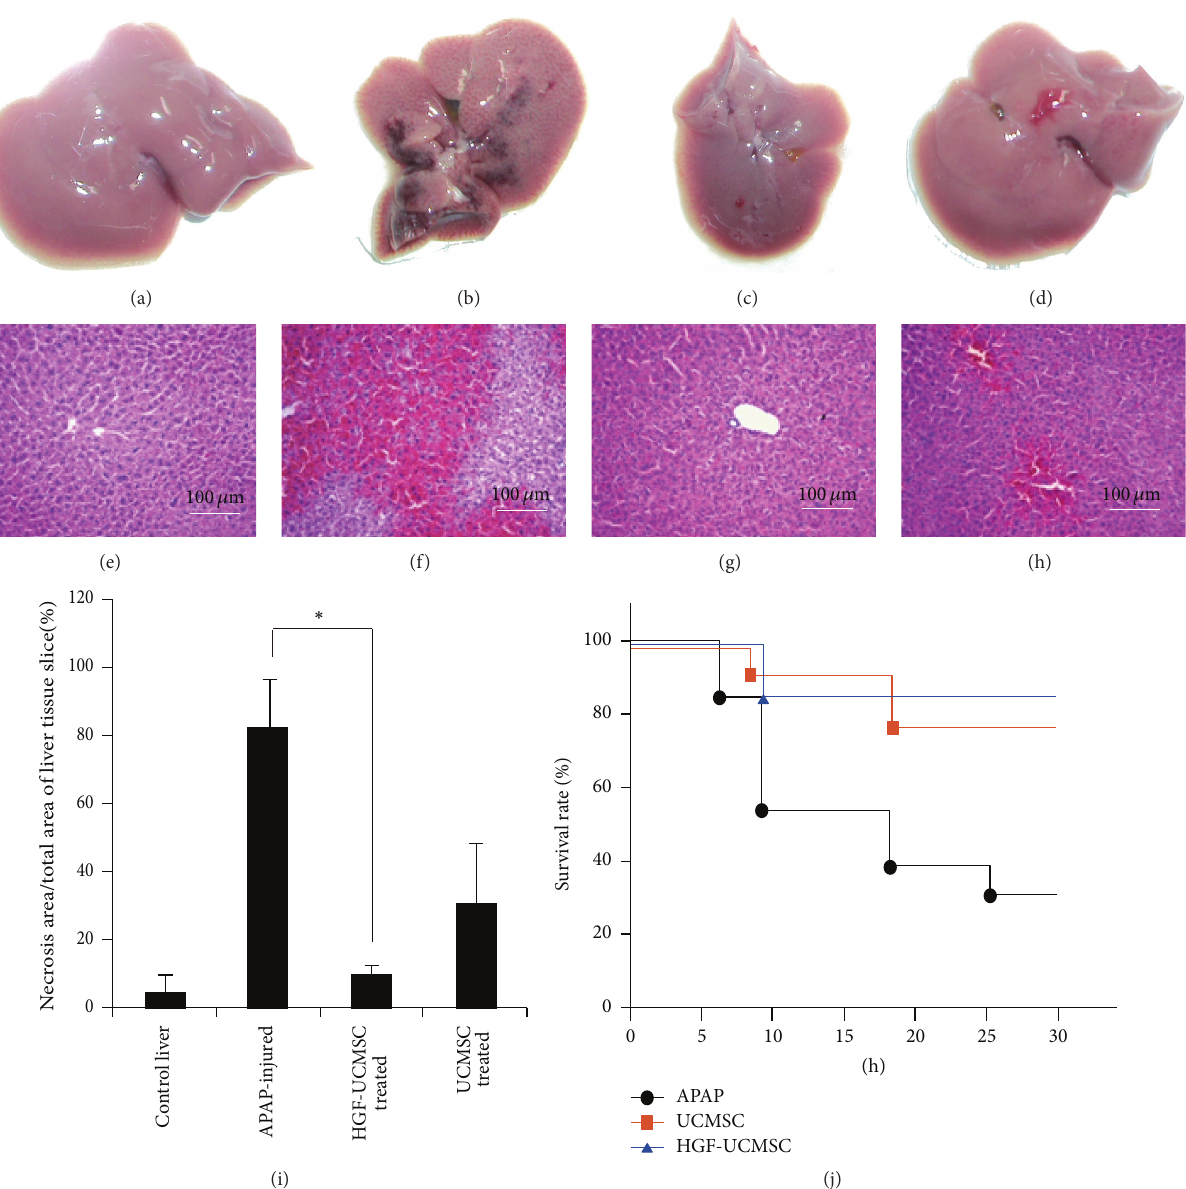
Figure 2: HGF-UCMSC treatment reduces hepatic damage in ALF mice. (a–d) Morphological analysis of the liver. (e–i) HE staining of the necrosis area in liver sections in ALF mice induced by 750 mg/kg acetaminophen. (j) Treatment with HGF-UCMSC and UCMSC significantly prolonged the survival of mice that received a lethal dose of Acetaminophen compared with nontreated